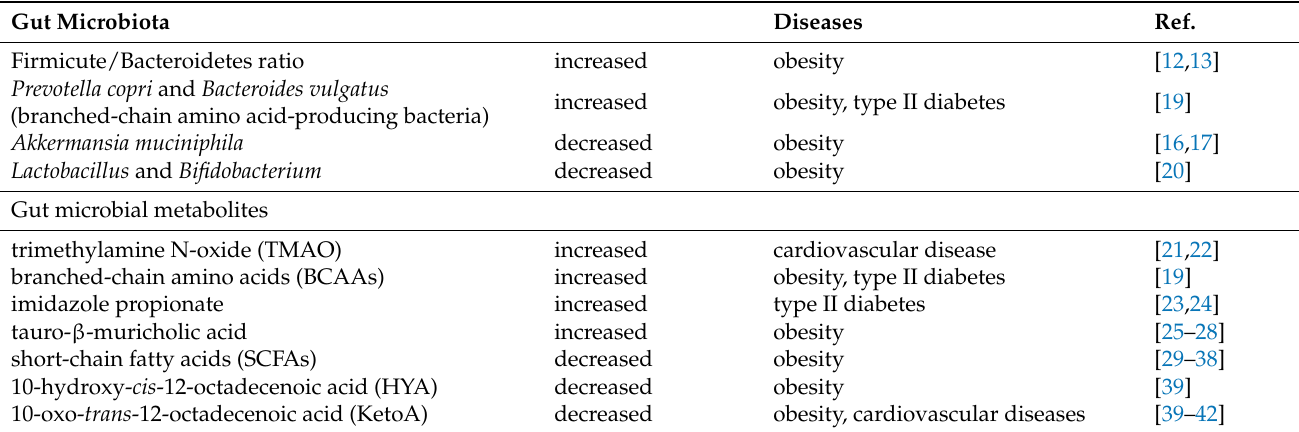
Table 1. Metabolic disorders-related gut microbiota and